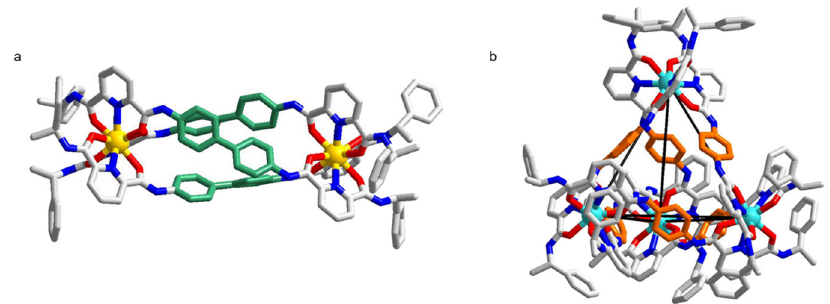
Fig. 3 X-ray crystal structure of lanthanide supramolecular complexes. a X ray crystal structure of [Tb 2 L2 SS 3 ] showing a helicate structure. b X ray crystal structure of [Eu 4 L1 SS 6 ] showing a